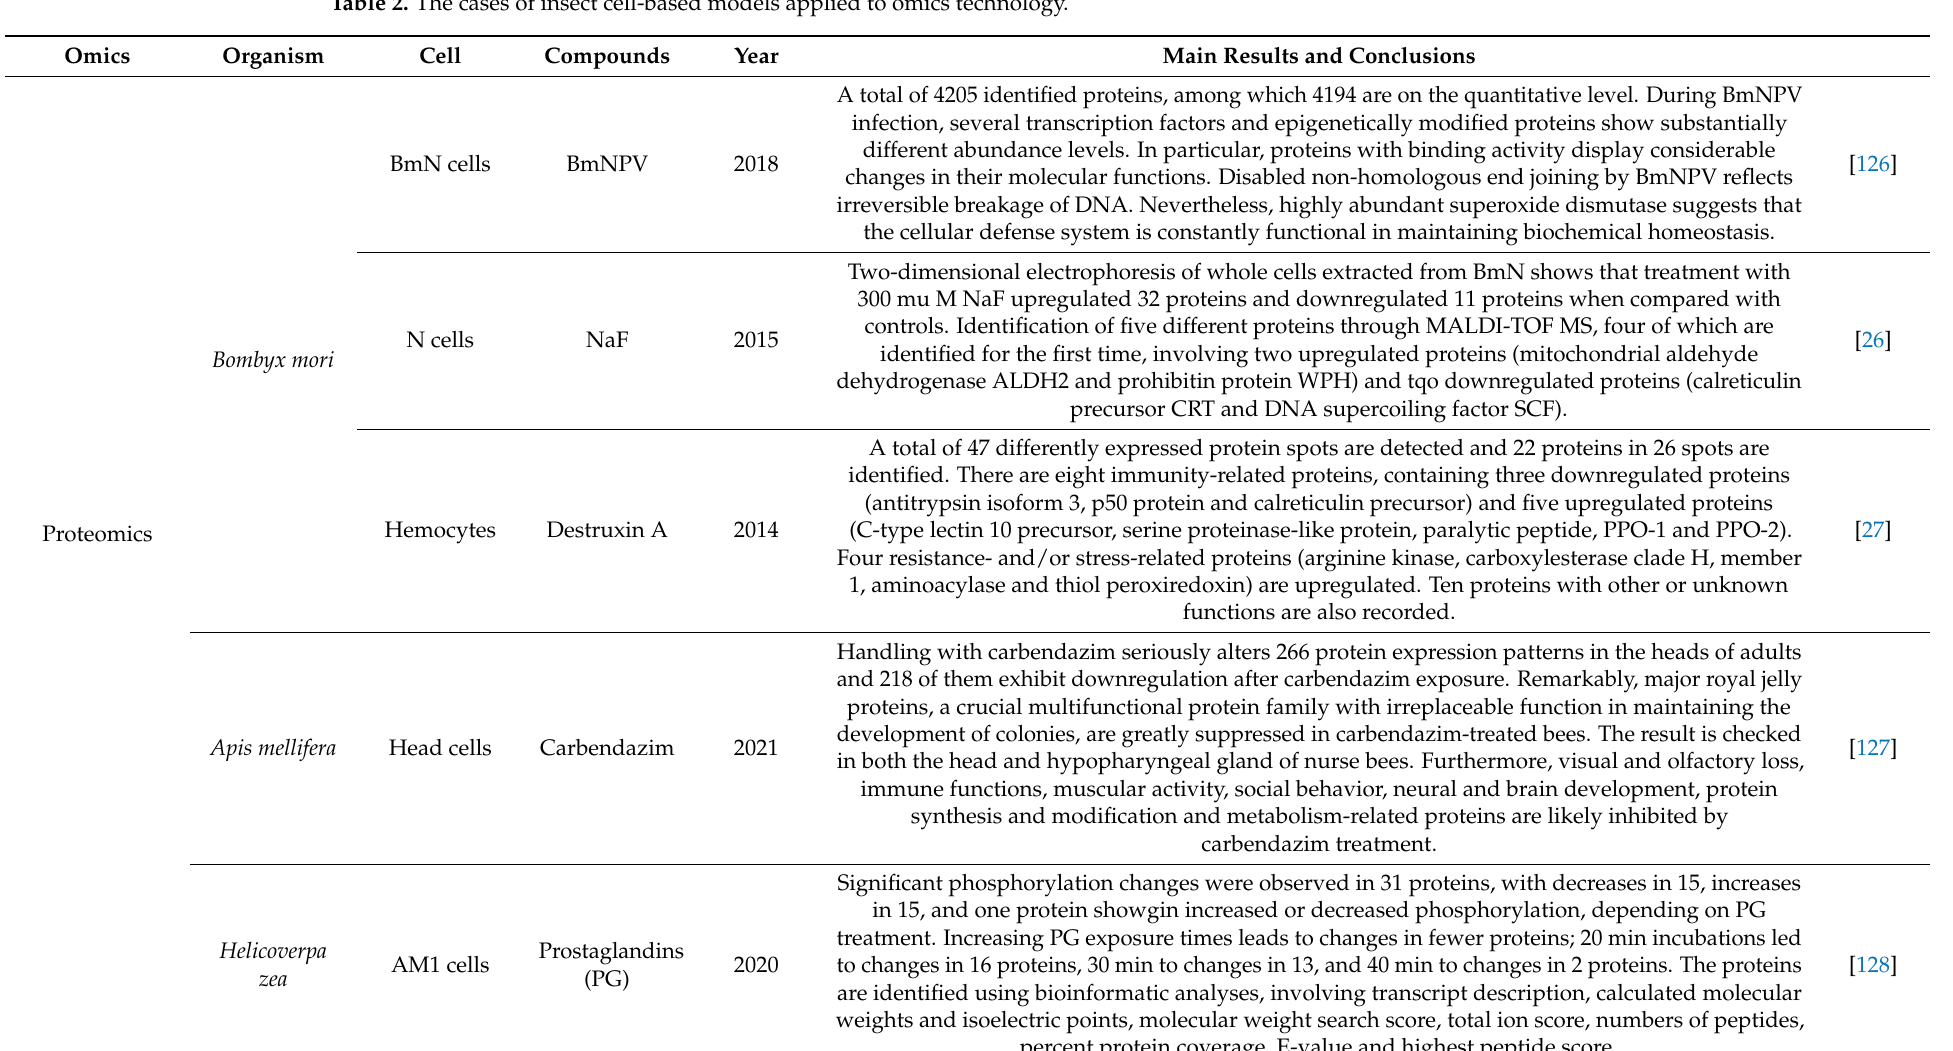
Table 2. The cases of insect cell-based models applied to omics